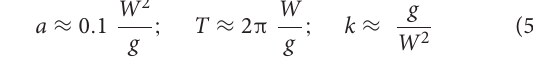
TABLE 2 | Density range and depth limits of the water mass in the region of the Aracati Bank (Barnier et al., 2001). Density range Water masses Depth range at σ θ <